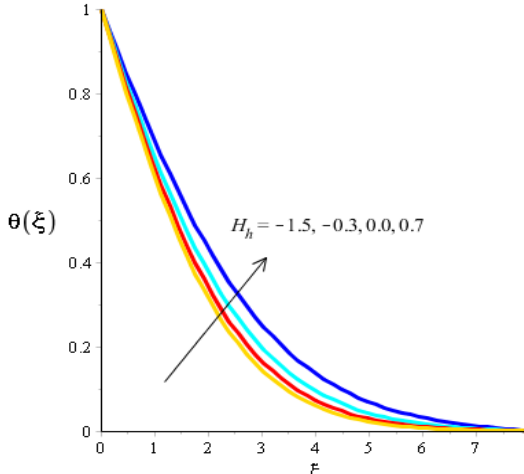
Figure 9. Analysis of the temperature curves versus H h .